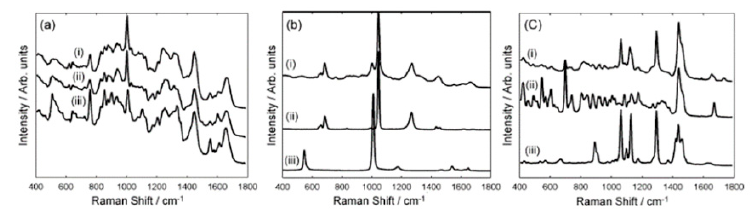
Figure 6. Comparison of tear spectra to biochemical standards, ( a ) proteins, (i) tear sample, (ii) human lactoferrin, (iii) human lysozyme, ( b ) metabolites, (i) tear sample, (ii) sodium bicarbonate, (iii) urea, and ( c ) lipids, (i) tear sample, (ii) cholesterol, (iii) palmitic acid [115].